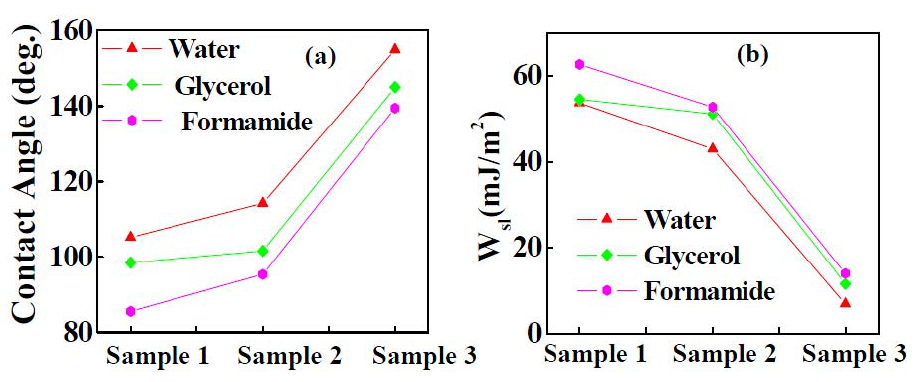
Table 2. Static contact angles of the probe liquids for reactively sputtered Y